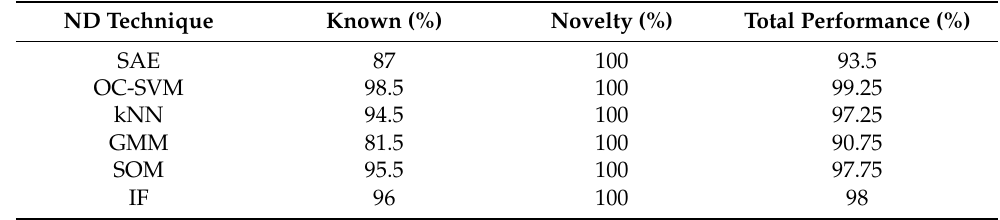
Table 6. Numerical results of the novelty detection obtained for the second case study of the SPG_DS.